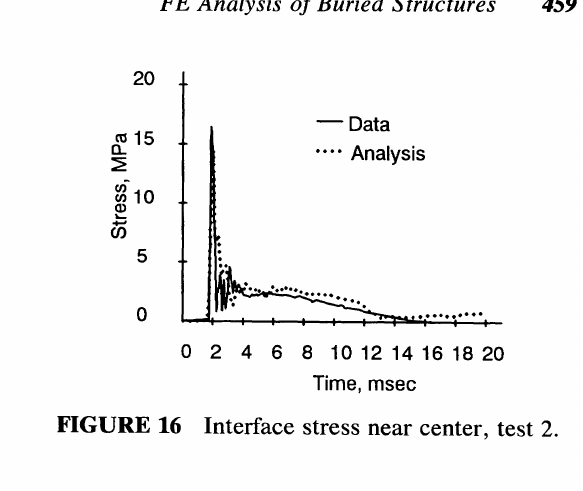
FIGURE 16 Interface stress near center, test 2.